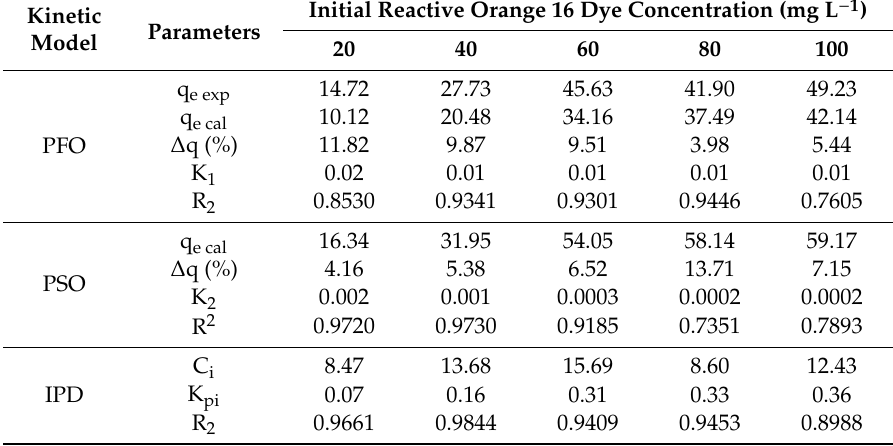
Table 4. Parameters and constants of PFO, PSO and IPD kinetic models